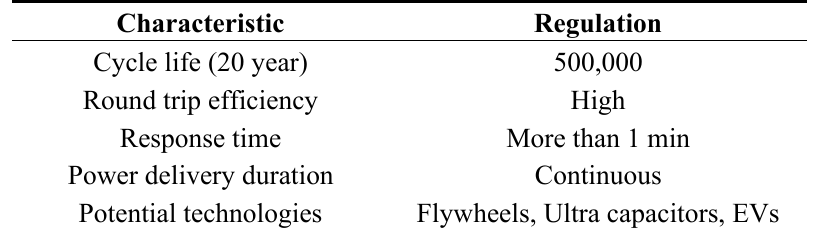
Table 1. Required energy storage characteristics to provide regulation